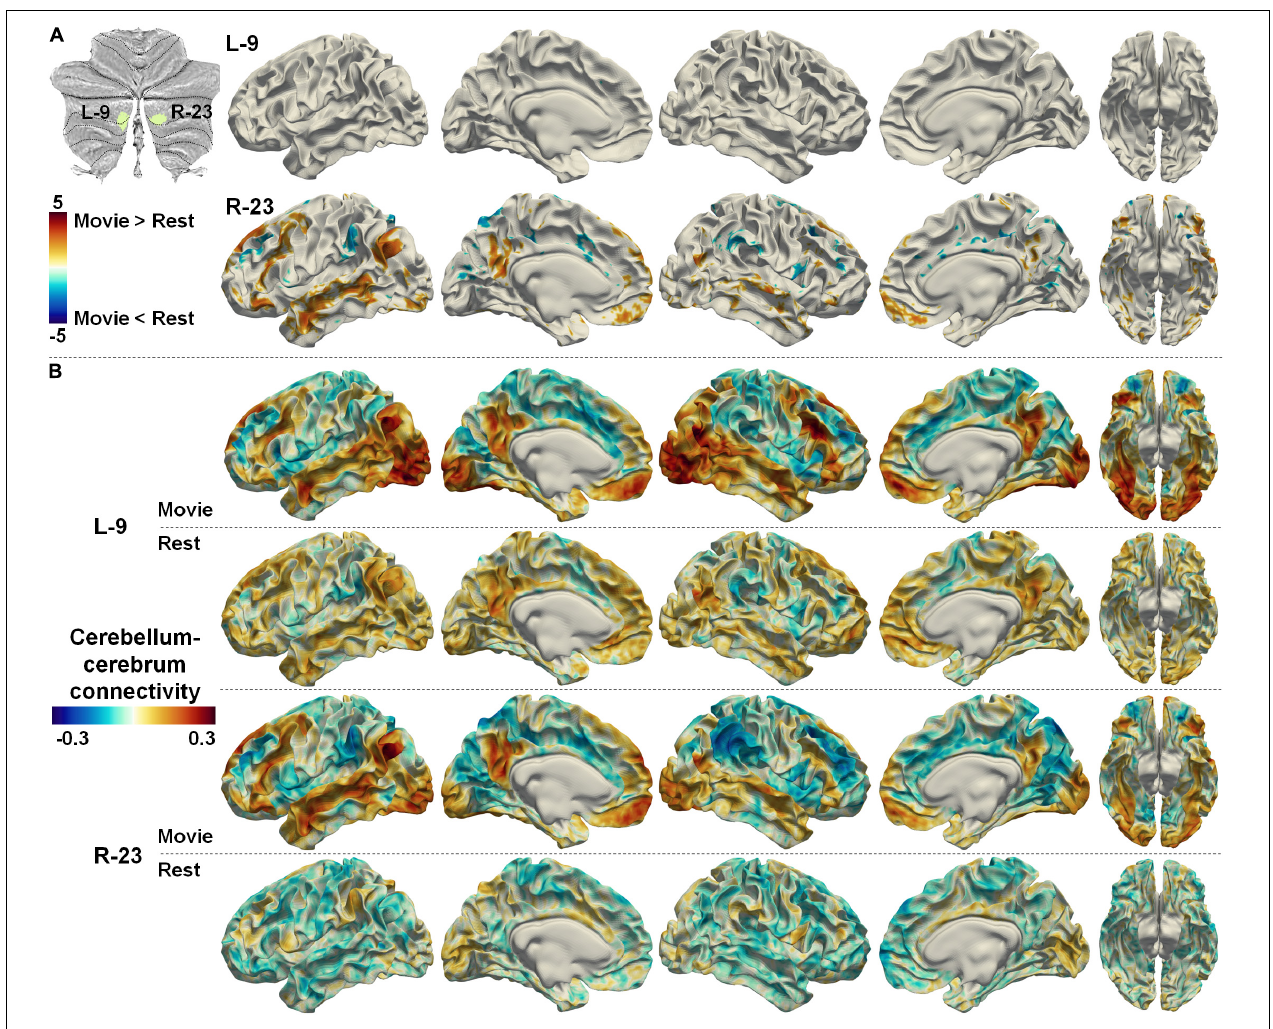
FIGURE 8 | (A) The difference between cerebellum–cerebrum connectivities in nfMRI and rsfMRI for two symmetrical regions (L-9 and R-23, related to auditory/language) in the Movie 64 parcellation. (B) The strength of cerebellum–cerebrum connectivities for the two regions in nfMRI and